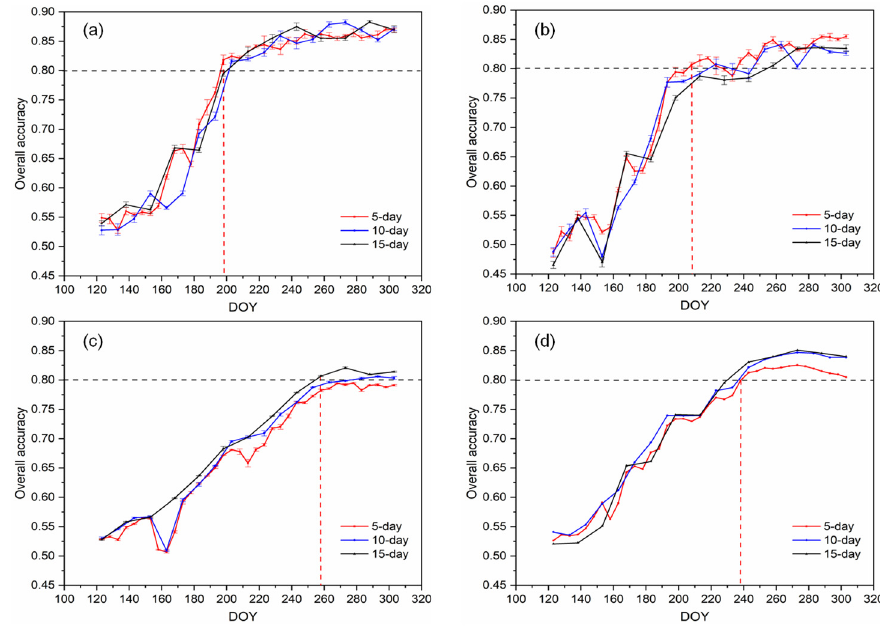
Figure 7. Changes in the overall accuracy based on the four classifiers and the time-series of Sentinel-2 data with different time intervals (5-day, 10-day, and 15-day) in the in-season crop classification using the ( a ) Conv1D network, ( b ) LSTM, ( c ) RF, and ( d ) SVM.